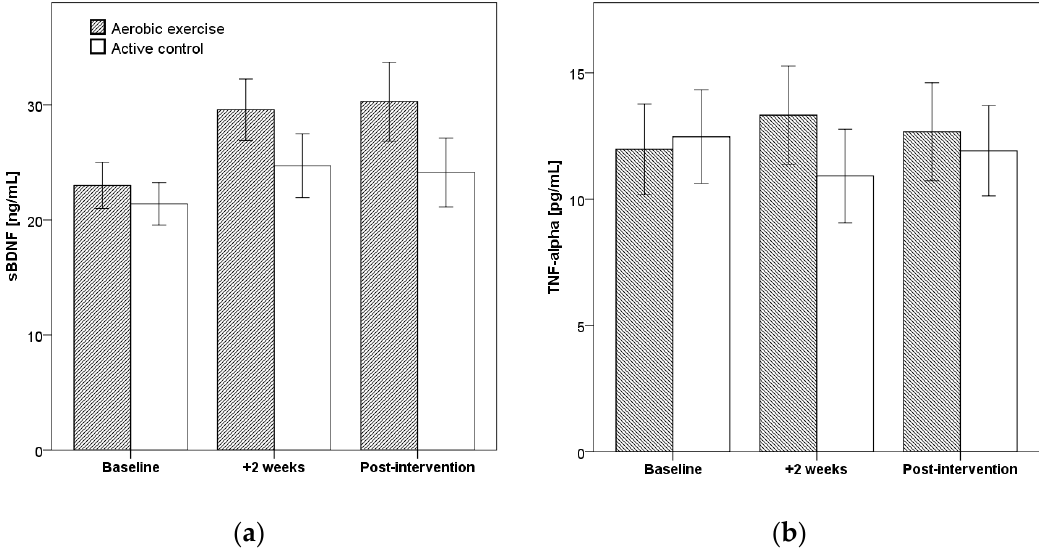
Figure 2. Serum levels of sBDNF ( a ) and TNF-alpha ( b ) at each timepoint by group. Error bars represent standard error (SE).